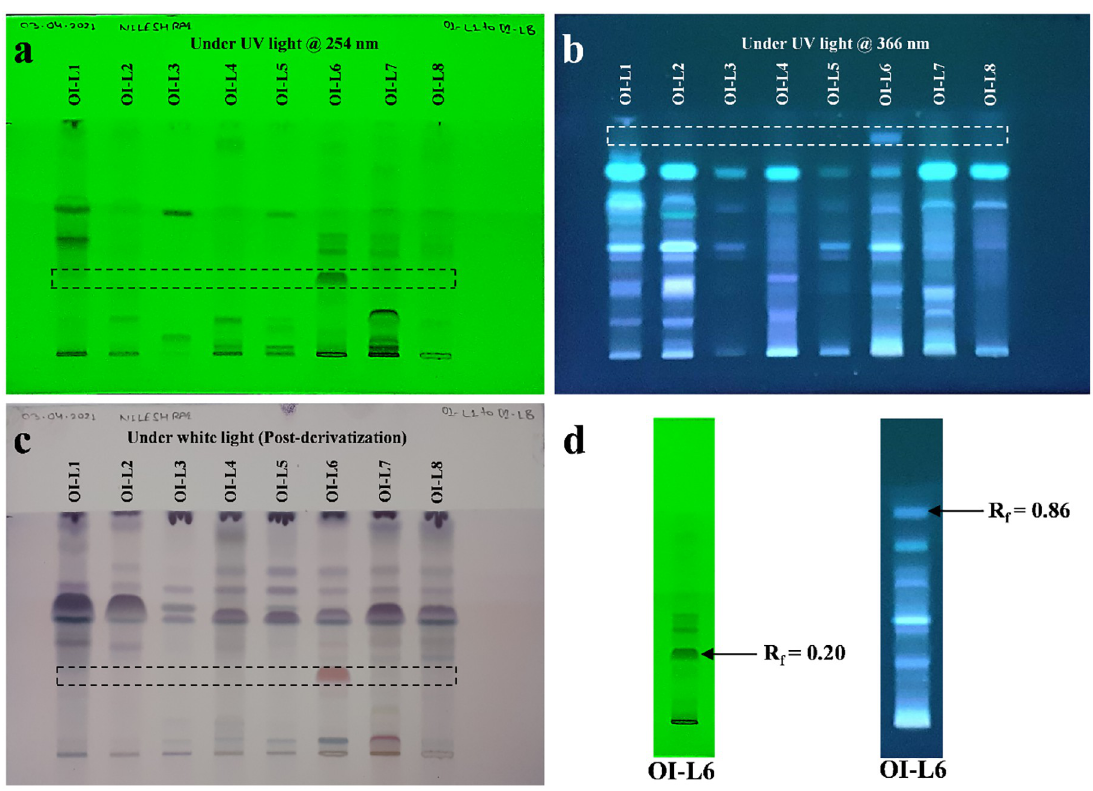
Fig 3. HPTLC fingerprint profiling of EA extract of fungal endophytes (a) TLC plate scanned at 254 nm, (b) TLC plate scanned at 366 nm, (c) TLC plate under white light after derivatization with anisaldehyde sulphuric acid reagent and (d) HPTLC fingerprint profiling of EA extract of fungal endophyte C . gloeosporioides showing unique bioactive component with respective value of retention factor (R f ).